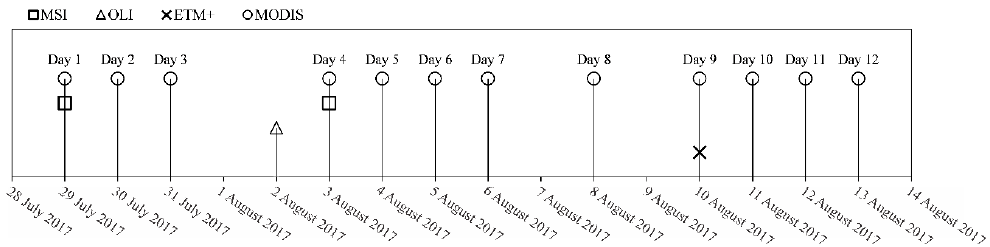
Figure 3. Dates of the sensor images used in the daily data fusion procedure.